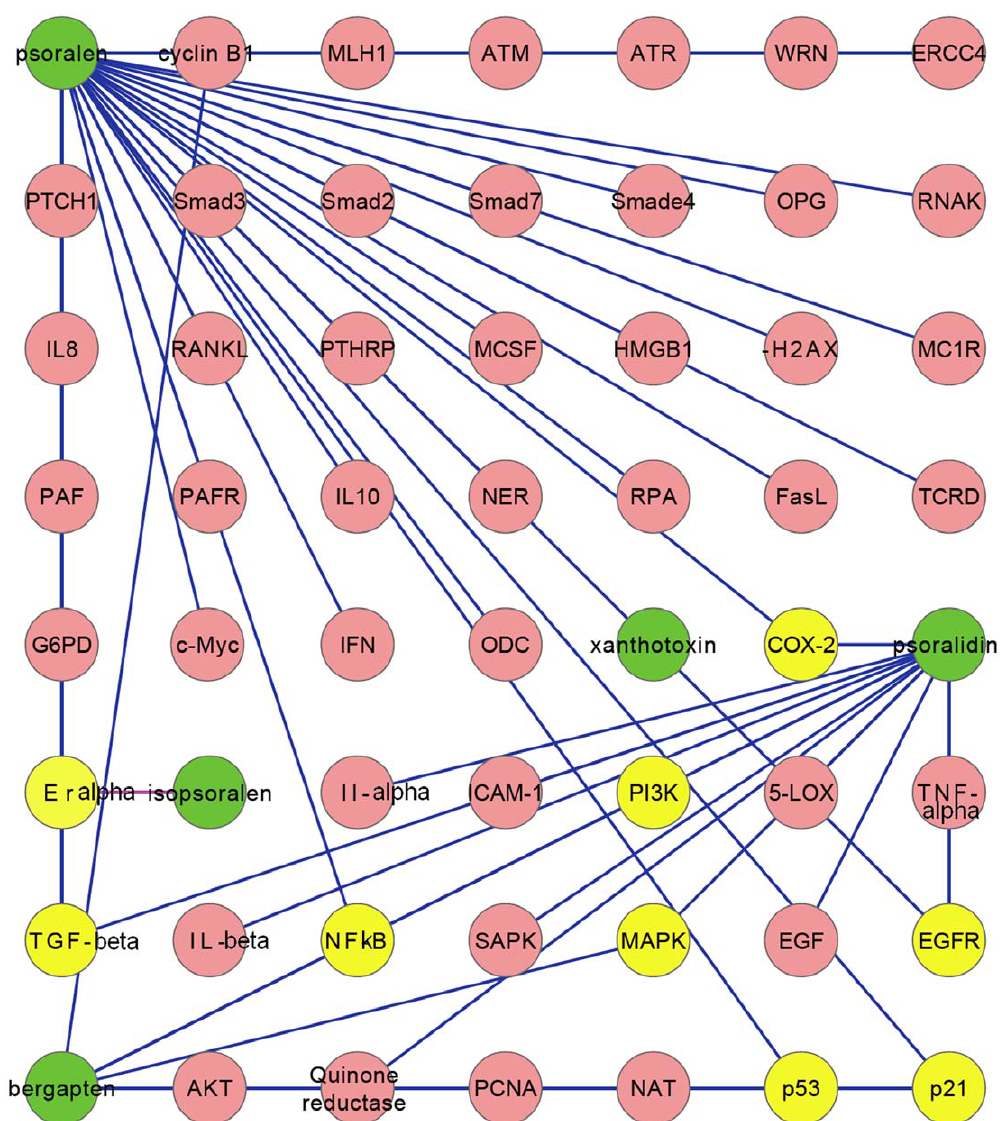
Figure 5. The drug–target association network (D–T network) for BZ. Green, the five compounds from BZ; Pink, the target-associated genes; Yellow, the shared genes among the five